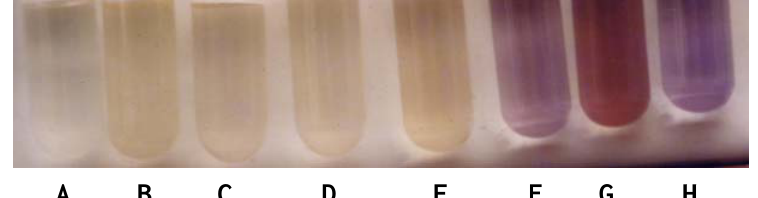
Figure 3. Detection of M. neoaurum exochelin in spent supernatants of M. neoaurum grown in various iron